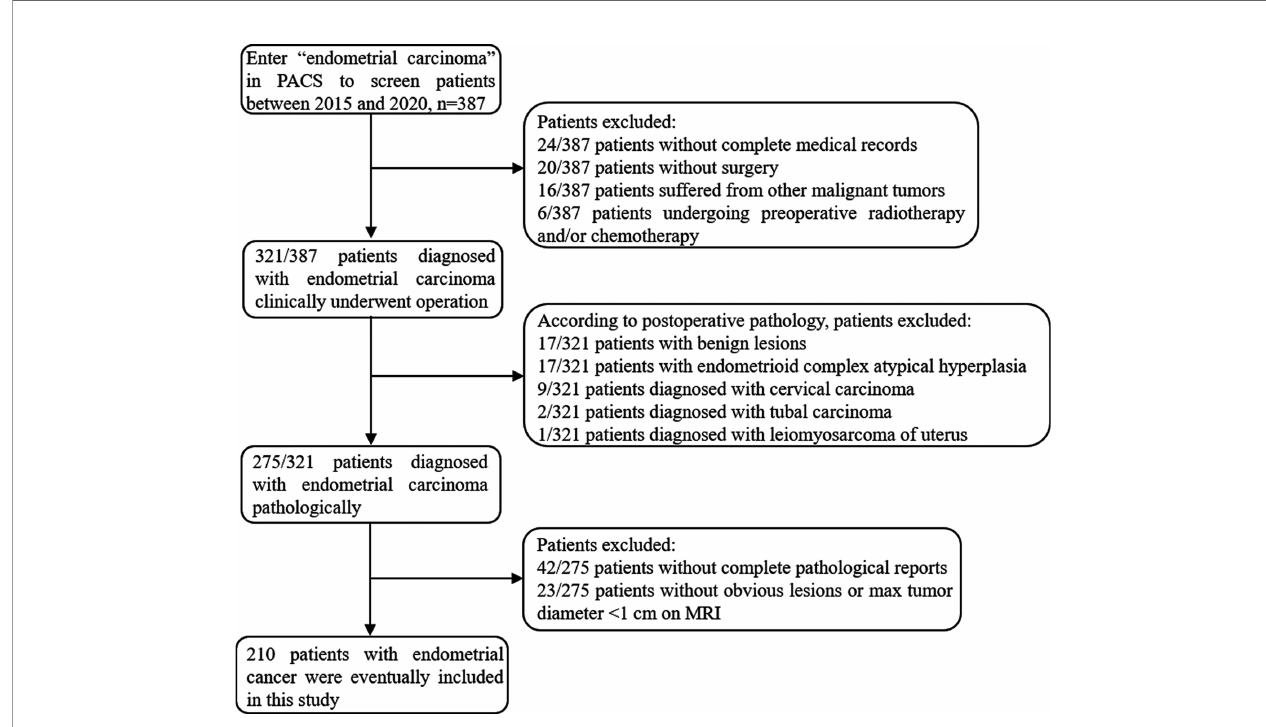
FIGURE 1 | Flowchart shows selection of study population and exclusion